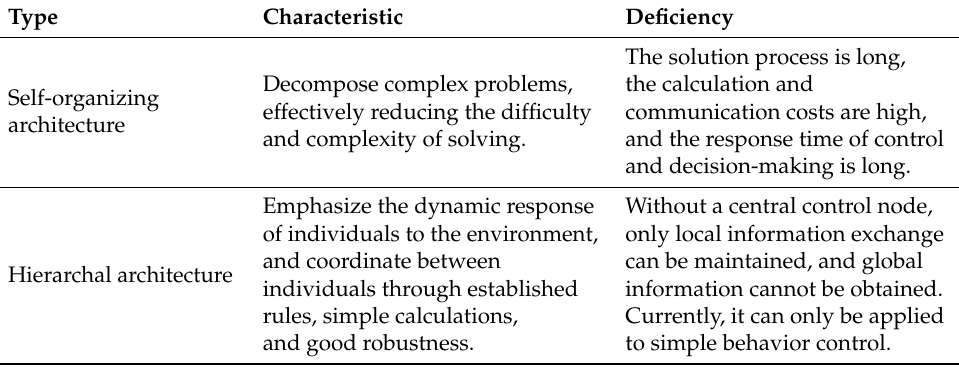
Table 4. Comparison of architecture characteristics of top-down and